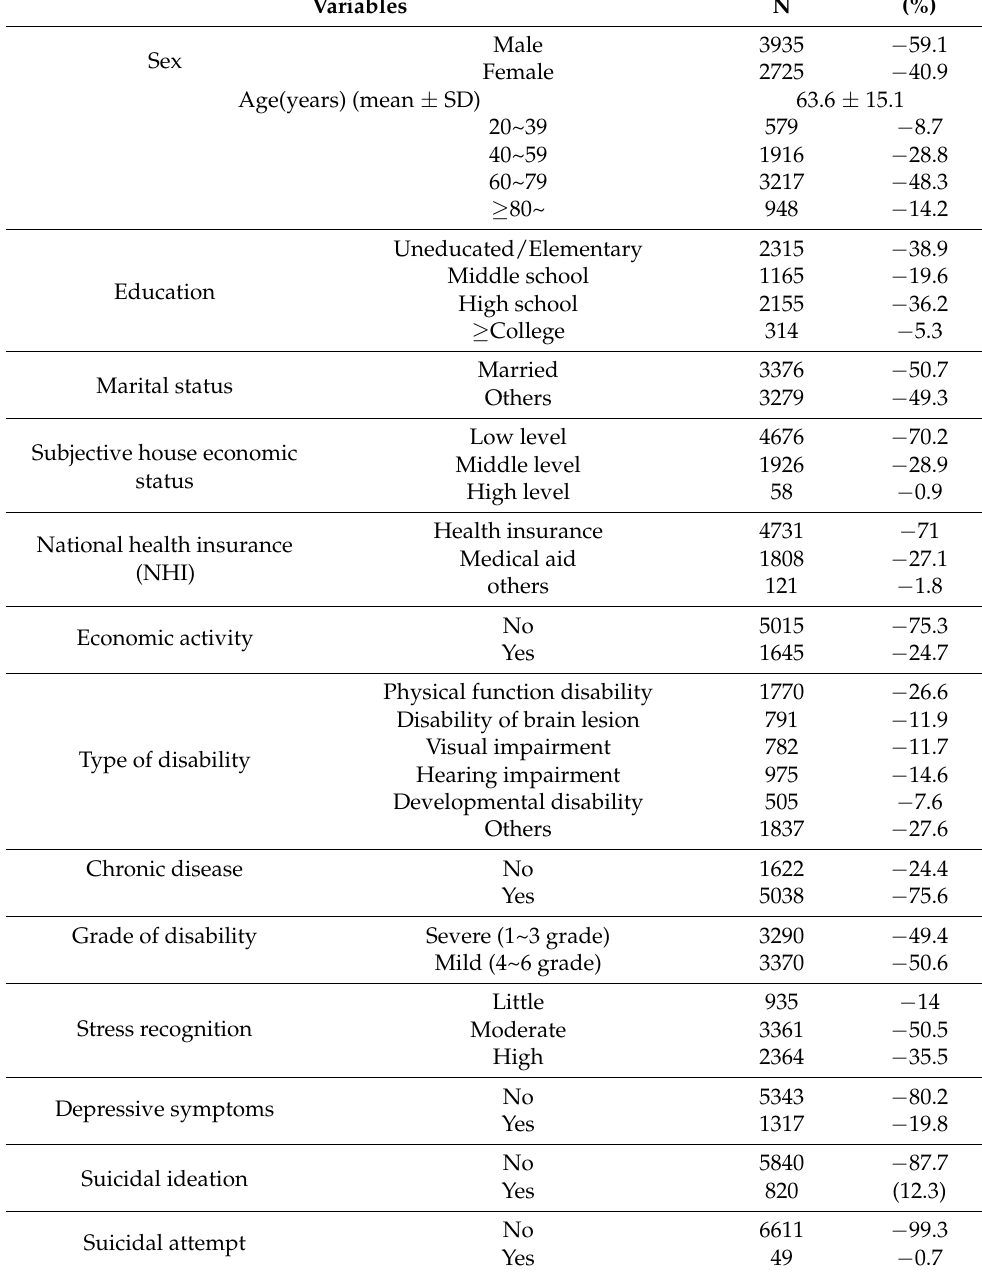
Table 1. Characteristics of the subject of study (N =